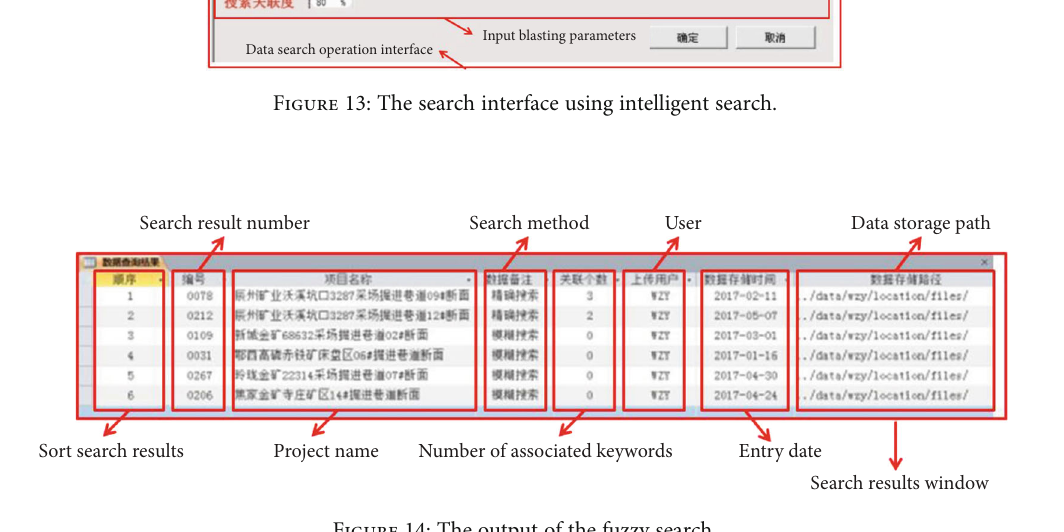
Figure 14: The output of the fuzzy search.